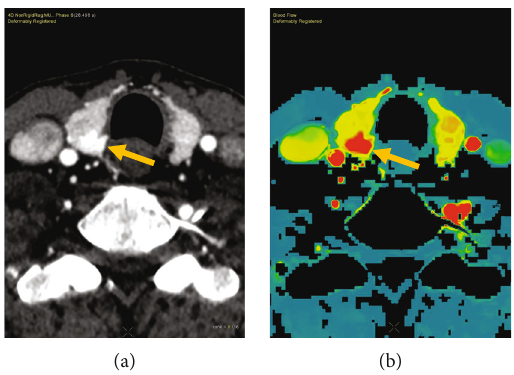
Figure 2: (a) 4DCT. On the arterial phase, we fi nd a large intrathyroidal parathyroid adenoma (arrow). (b) Parametric perfusion map, color-coded overlay of BF values. Note the elevated BF in the parathyroid adenoma as compared to the thyroid